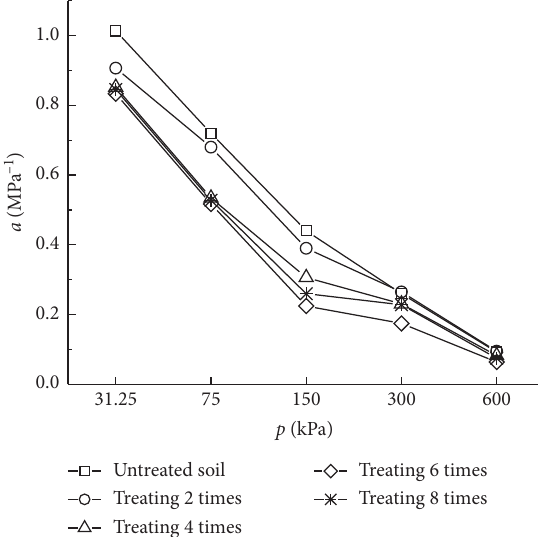
Figure 4: Relations between a and p